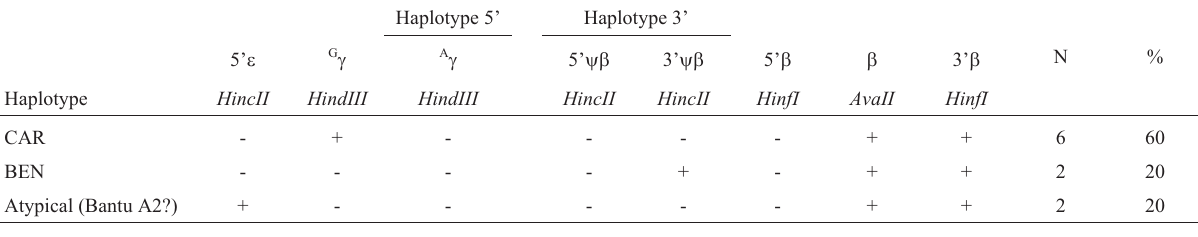
Table 3 - (cid:3) S haplotypes in individuals heterozygous and homozygous for sickle cell